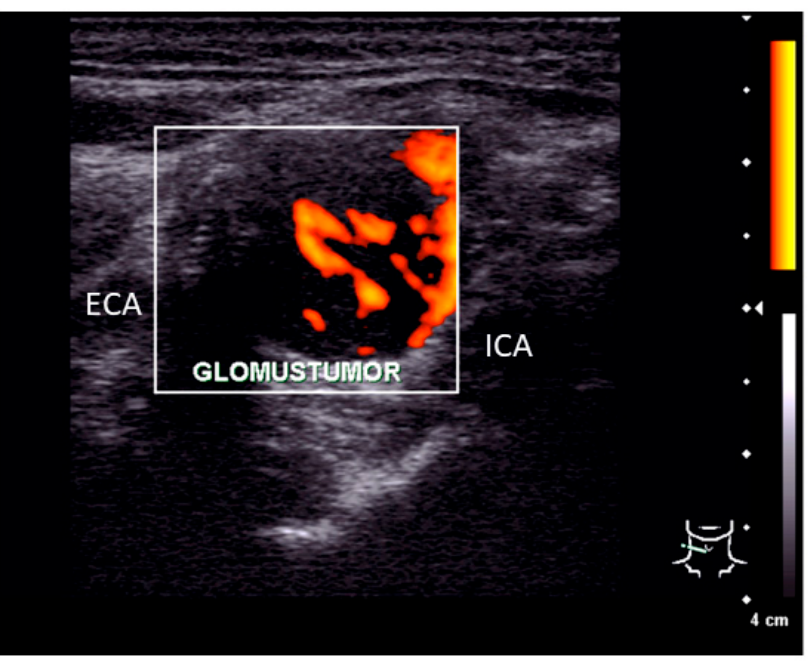
Figure 2. Ultrasonography finding. Pre-operative ultrasonography examination showed a 2.6 × 2.1 × 1.3 cm measuring tumor located between the internal (ICA) and external carotid artery (ECA) with a strong vascularization.